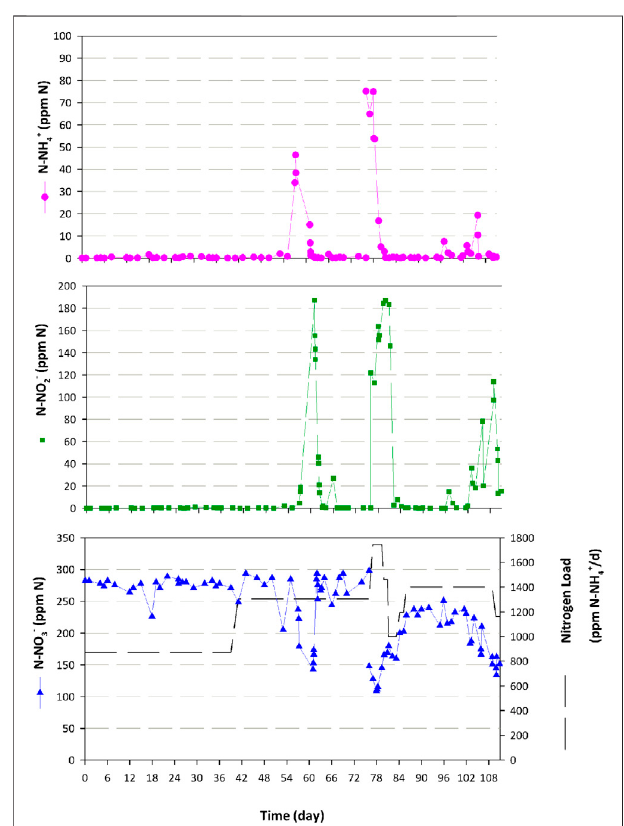
FIGURE 9 | Nitrogen species at the nitri fi cation compartment outlet during the integration experiments where Compartment 3 and 4a are connected in the liquid phase and Compartment 4a and 5 in the gas phase. [ Dotted pink: N-NH 4+ (ppm); Square green: N-NO 2- (ppm); Triangle blue: N-NO 3-